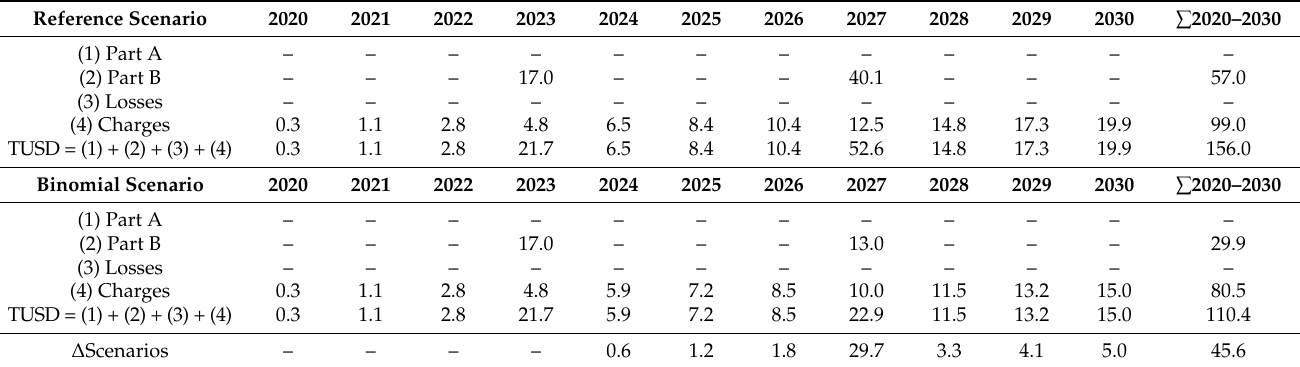
Table 10. Economic effects of MMDG for Enel Cear á , in million